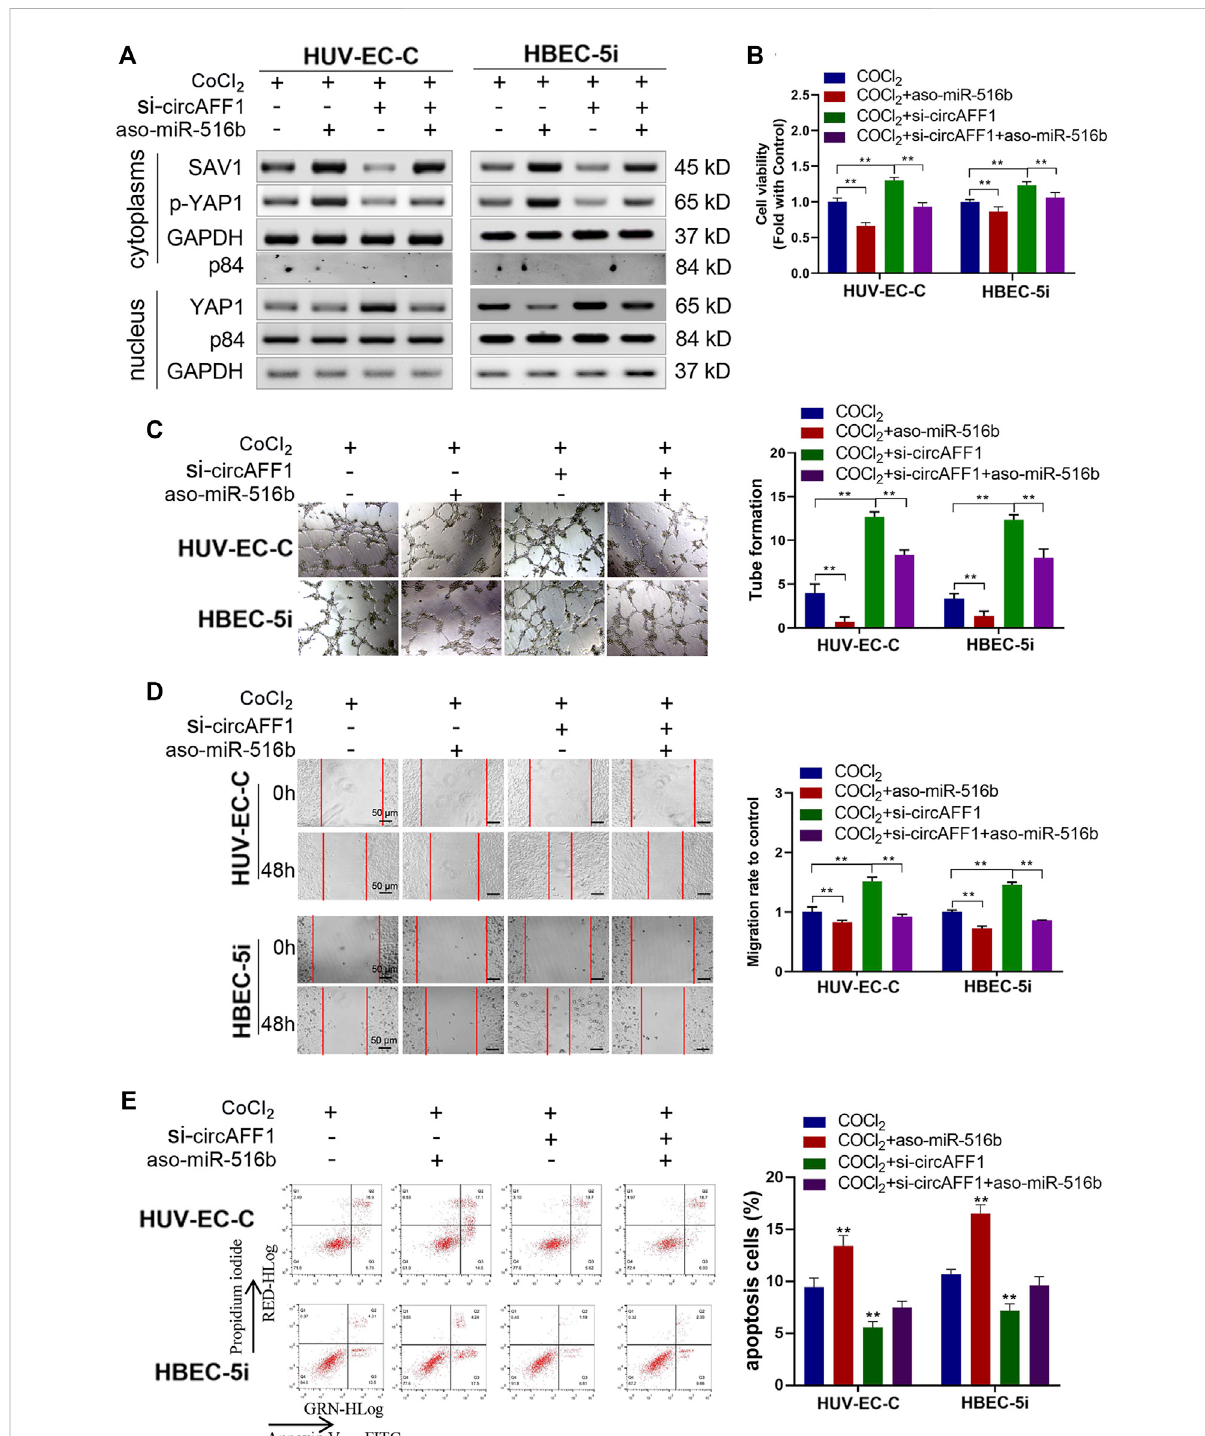
FIGURE 7 miR-516breversedtheeffectofcircAFF1onendothelialcells. (A) WesternblotanalysisdemonstratedthatcircAFF1cancounteractthein fl uenceofmiR- 516b mimics on SAV1, YAP1, and p-YAP1 expression in HUV-EC-C and HBEC-5i cells. (B) CCK-8 assay indicated that the proliferation ability of HUV-EC-C andHBEC-5icellstransfectedwithaso-miR-516bwasreversedwhenco-transfectedwithsi-circAFF1. (C) TubeformationabilityofHUV-EC-CandHBEC-5i cells transfected with aso-miR-516b was reversed when co-transfected with si-circAFF1. (D) Wound healing assays indicated that the migration capabilityofHUV-EC-CandHBEC-5icellstransfectedwithaso-miR-516bwasreversedwhenco-transfectedwithsi-circAFF1. (E) Apoptosisassayindicated that the apoptosis ability of HUV-EC-C and HBEC-5i cells transfected with aso-miR-516b was reversed when co-transfected with si-circAFF1. Data are presented as means of three experiments, and error bars represent SD (** p <